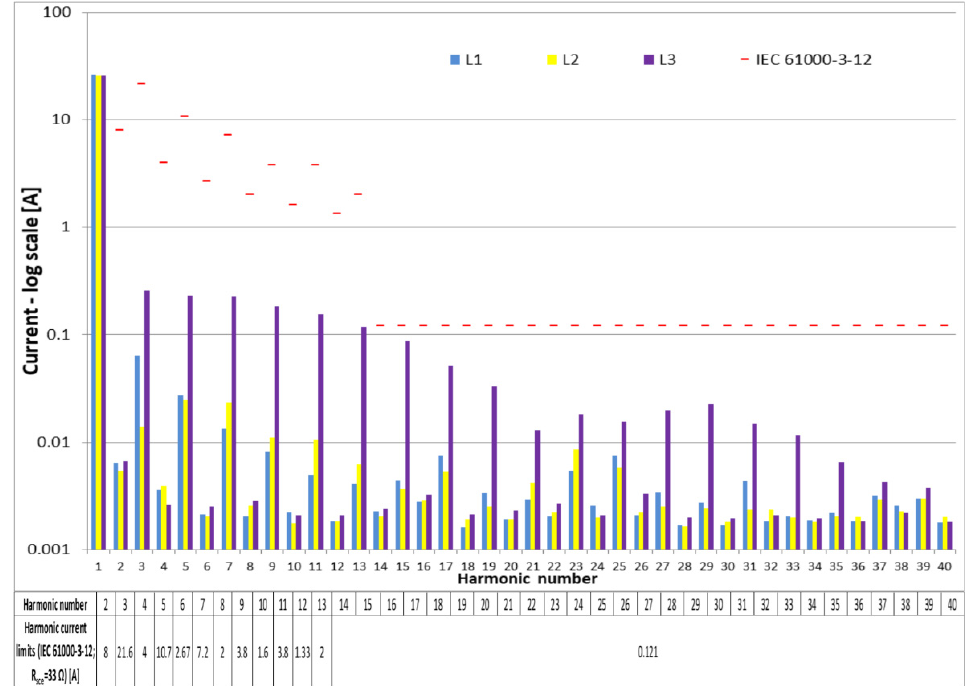
Figure 7. The harmonic current spectrum of an AC module (80% of power).